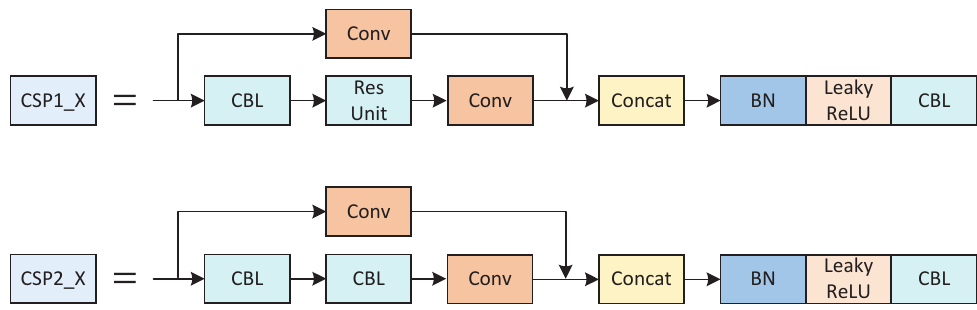
Figure 8. Flow charts of CSP1_X and CSP2_X. (3) Neck: CSP2_X structure.